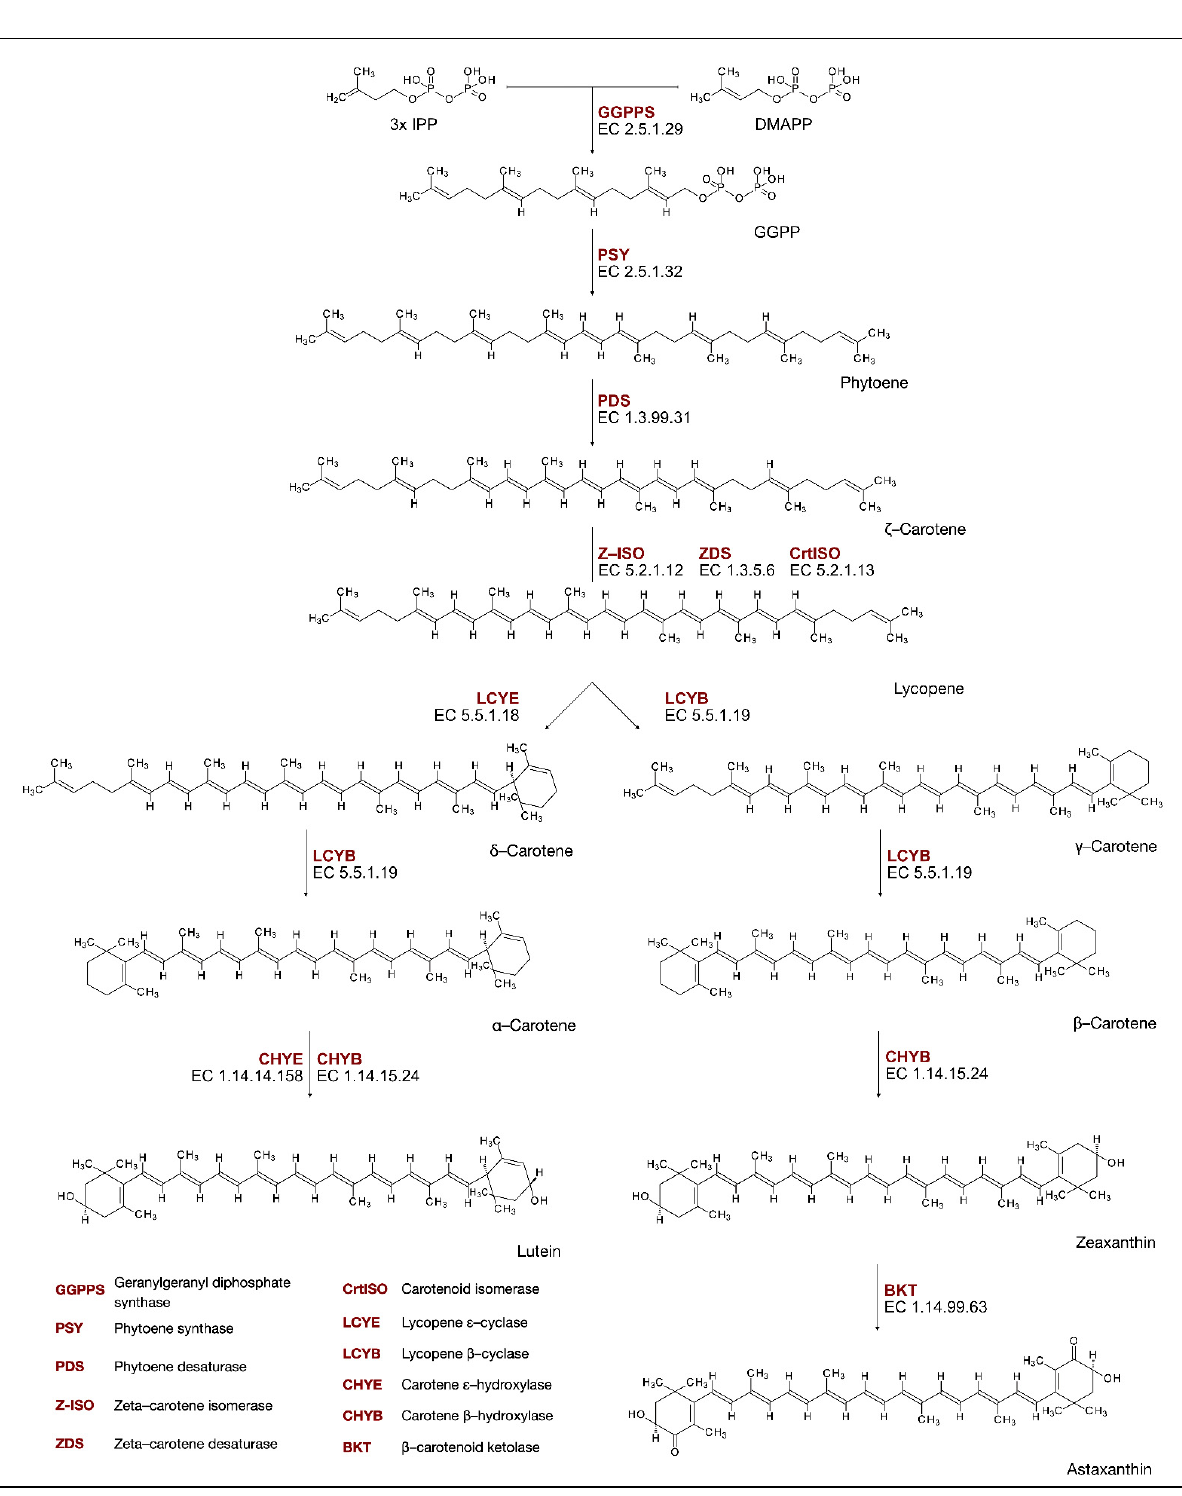
Figure 3. Carotenoids biosynthesis pathway.